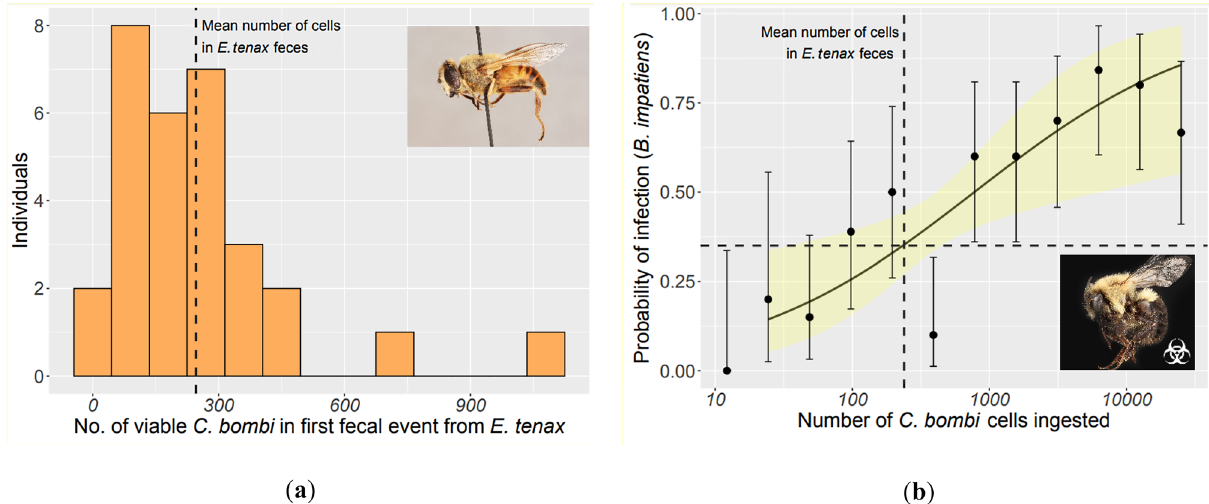
Figure 1. Flower flies can defecate enough live Crithidia bombi cells to infect bumble bee hosts: ( a ) Total number of C. bombi cells found in the first fecal events of inoculated Eristalis tenax flies ( n = 30); ( b ) Probability of C. bombi infection of inoculated Bombus impatiens bumble bees ( n = 9–12 per dose). In both figures, the vertical dotted lines indicate the mean number of C. bombi (239 cells) defecated in the first fecal events of E. tenax flies . In figure ( b ), the horizontal dotted line indicates that the probability of infection at 239 cells is 35%. 95% confidence intervals are shown as error bars for each treatment and the shaded area on the dose– response curve. “Side view of Eristalis tenax ” image by Ken Perry, licensed under CC0 1.0. “Side view of Bombus impatiens ” image by Christopher Johnson, licensed under CC0 We found that all treatments but the 12-cell dosage of C. bombi could infect bumble bees. The lowest infective dose (24 cells) had a 14% likelihood of bee infection and the highest dose (25,000 cells) had an 85% likelihood of bee infection. When we mapped the levels of C. bombi found in inoculated flower fly feces to the likelihood of infection using the dose–response curve, we found that all flower fly feces containing viable C. bombi could potentially infect B. impatiens . The lowest quantity of C. bombi parasites defecated by a fly was 60 cells, which had a 24% likelihood of bee infection (Fig. 1b). The highest quantity of C. bombi parasites defecated was 1080 cells, corresponding to a 54% likelihood of infection if consumed by B. impatiens . The mean quantity of C. bombi parasites (239 cells) corresponds to a 35% likelihood of infection if consumed by B. impatiens (Fig. 1b). Vectoring potential of two bee species, Osmia lignaria and Megachile rotundata , and two Er- istalis fly species, E. arbustorum and E. tenax . Fecal volumes and defecation frequency. All pollina- tors were placed in individual cages lined with filter paper and fed ad libitum sucrose solution with fluorescent powder to measure fecal volumes and defecation frequency in a 24-h period. When comparing fecal volumes between different species and sex using the filter paper data only (which used identical methodology for all pol- linators), we found that the species-sex interaction was significant ( F (3, 457) = 10, p < 0.001; Fig. 2), so main effects were not tested in accordance to principle of marginality. Based on post-hoc pairwise contrasts (Supplementary Table S1), we found that for both sexes, E. tenax had significantly larger fecal volumes than the three other pol- linator species, while E. arbustorum and O. lignaria both had larger fecal volumes than M. rotundata (Fig. 2). Within each species, only E. tenax showed a significant difference between sexes, with females having larger fecal volumes than males. For E. tenax only, comparing the fecal volumes from the two methods (collected from microcentrifuge tubes in the inoculation experiment vs. estimated from filter paper spot diameters), we found that the method-sex interaction was marginally significant ( F (1,126) = 3.9, p = 0.052), while both the main effects of method and sex were significant (method: F estimated using standard curves from filter paper spot diameters (Supplementary Figure S4). Nonetheless, since the interaction was not significant, this means that any inference about fecal volume differences between groups should not be affected by the choice of methods. Eristalis tenax flies defecated more frequently than E. arbustorum flies in a 24-h period ( F (1, 137) = 85, p < 0.001; Fig. 3). Uninfected E. arbustorum flies defecated, on average, 14 times in a 24-hour period and uninfected E. tenax flies defecated, on average, 32 times in a 24-hour period. Neither the species-sex interaction nor sex were important predictors of defecation frequency of E. arbustorum and E. tenax flies ( F (1, 136) = 0.24, p = 0.63; F (1, 137) = 2.2, p = 0.14). Defecation patterns on a shared floral resource. Defecation events were recorded on Solidago dansolitum ‘Lit- tle Lemon’ goldenrod in all cage trials with E. tenax flies ( n = 20 trials) and O. lignaria bees ( n = 10 trials), while E. arbustorum defecated on Solidago in only 8 of 10 trials. Both E. arbustorum and O. lignaria defecated on all